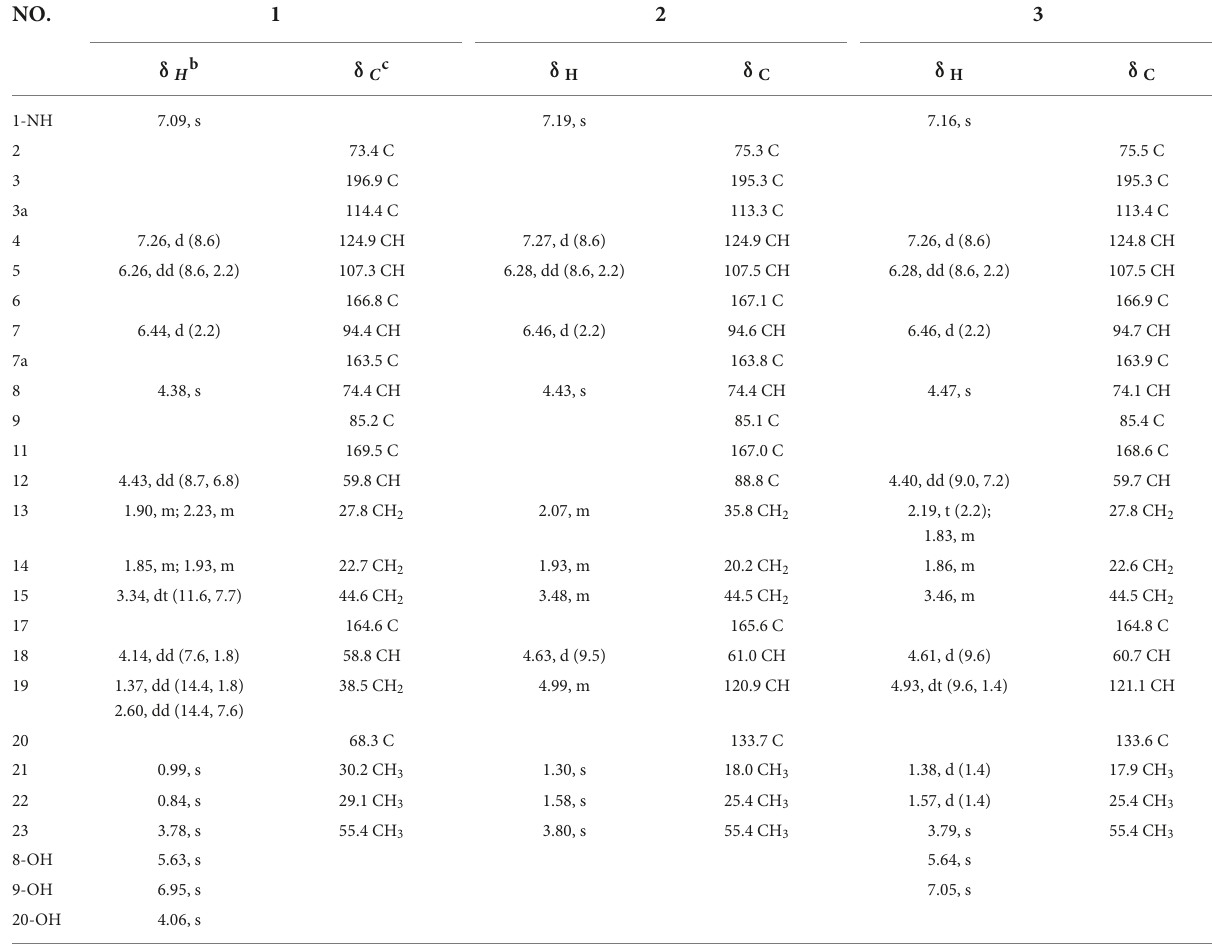
TABLE 1 1 H and 13 C NMR data ( δ in ppm, J in Hz) for compounds 1, 2, and 3 a